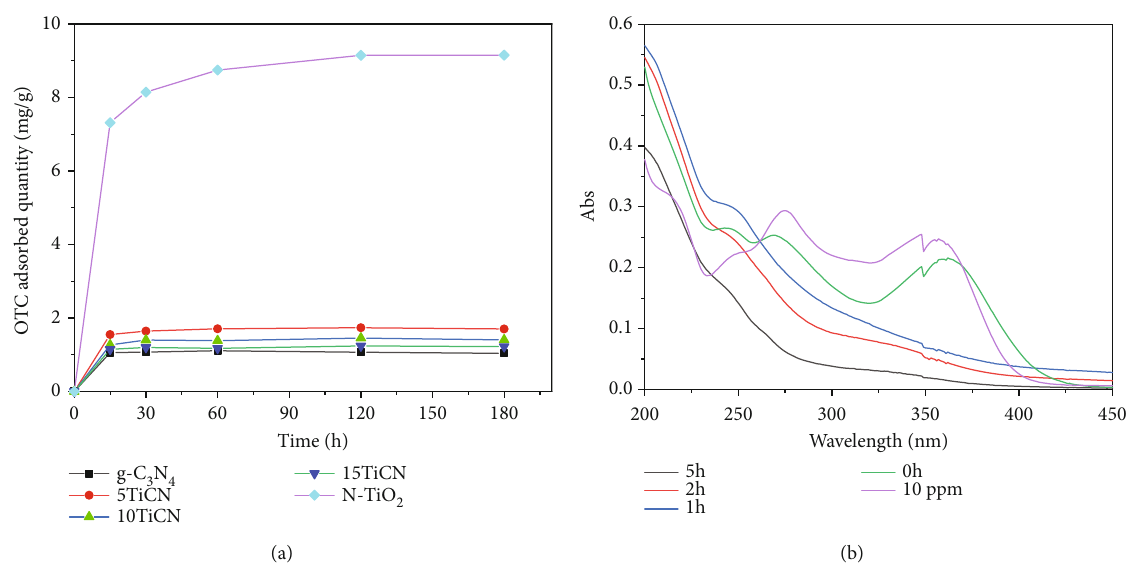
Figure 6: OTC adsorption equilibrium (a) on x TiCN and UV-vis spectra of OTC during test time on 5TiCN composite (b).